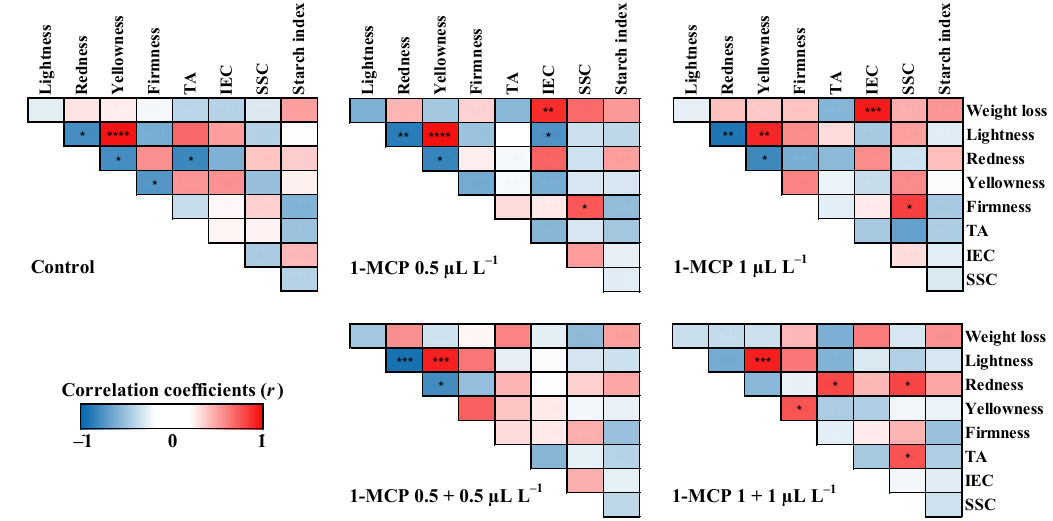
Figure 6. Pearson’s correlation coefficient ( r ) for fruit quality attributes in ‘Arisoo’ apples treated with 1-MCP at different concentrations and number of applications during cold storage at 0 ± 1 °C with 90–95% relative humidity for up to six months. Red and blue colors represent positive and negative correlation between variables, respectively. Asterisks (*, **, ***, or ****) represent statistically significant correlation at p < 0.05, 0.01, 0.001, or 0.0001, respectively. TA: titratable acidity; IEC: internal ethylene content; SSC: soluble solids content; L *: lightness; a *: red/green value; b *: blue/yellow value.